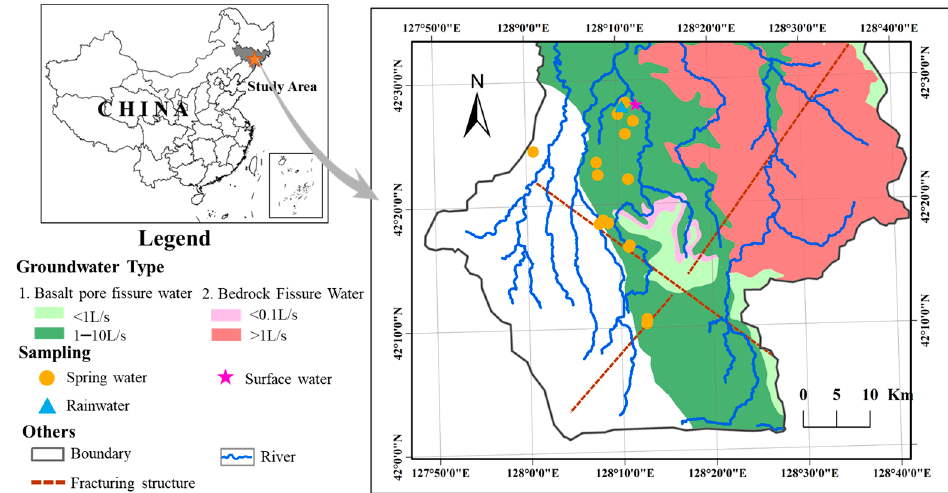
Figure 2. Hydrogeological map and sampling sites of the study area.